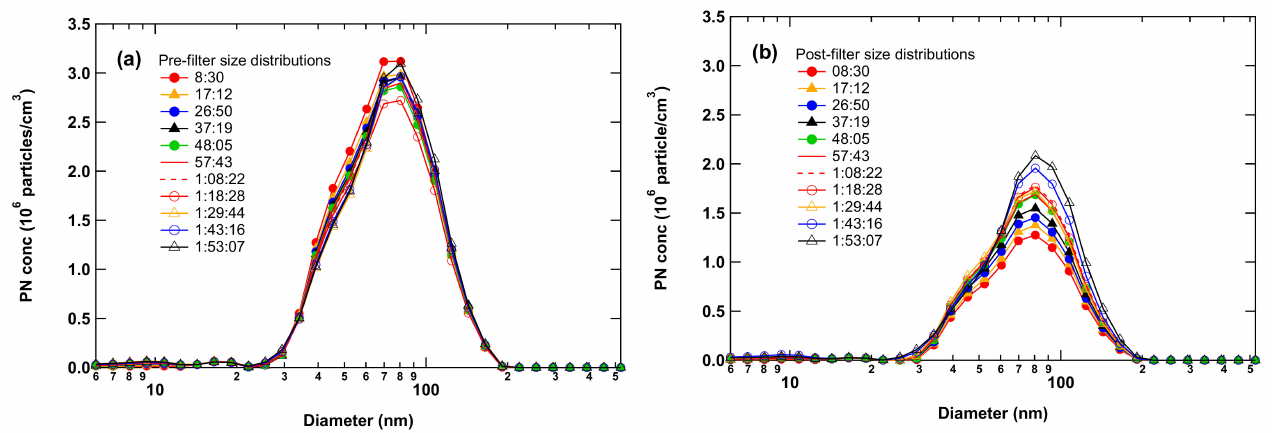
Figure 3. Example of the particle number size distribution measured at the ( a ) pre- and ( b ) post-cabin filter locations during a typical